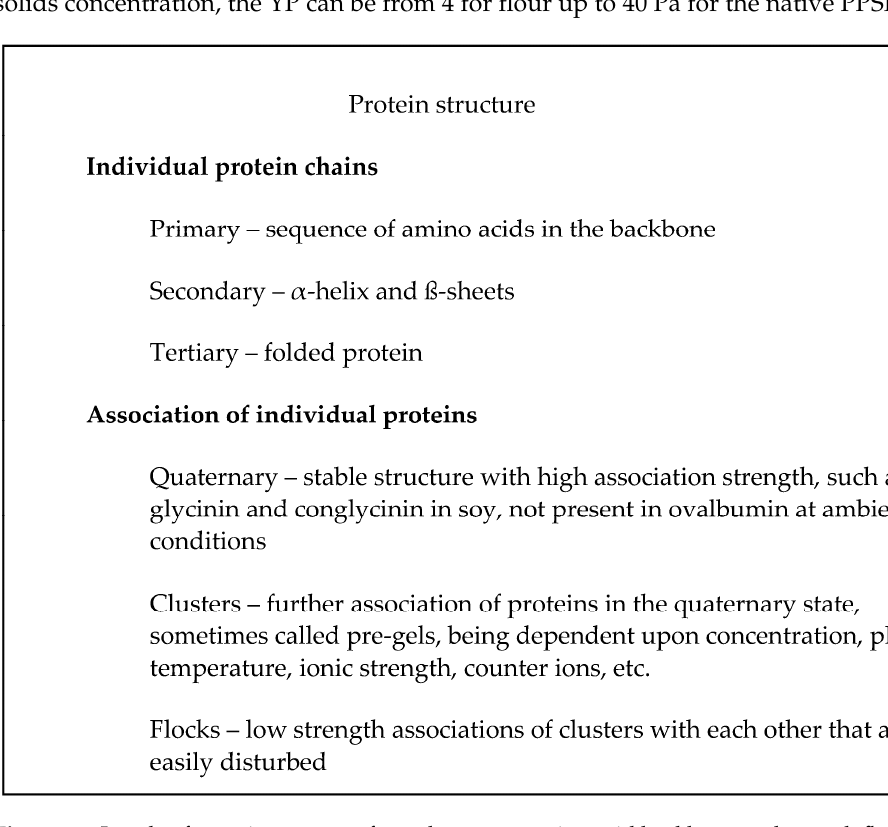
Figure 18. Levels of protein structure from the strong amino acid backbone to the weak flocks.